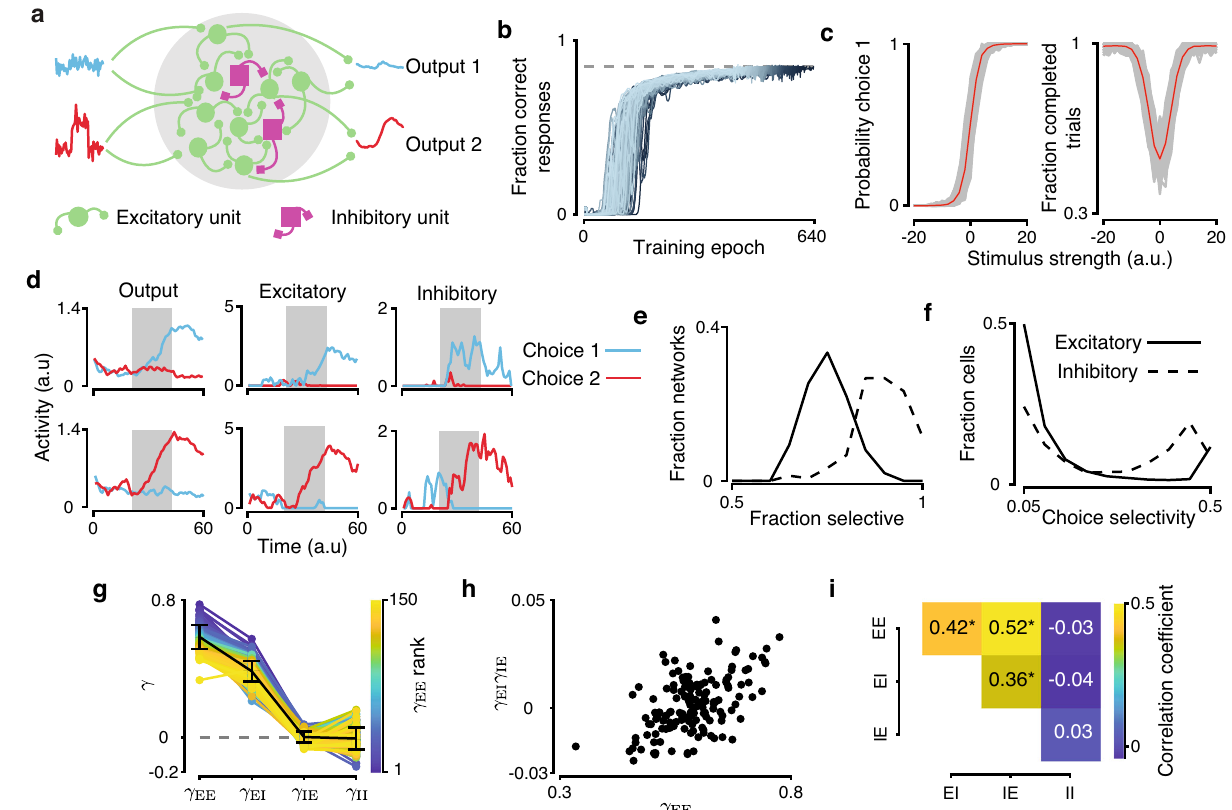
Fig. 5 | Inhibitory choice selectivity in trained recurrent neural networks. a RNNs are trained to compare two inputs and indicate which has higher mean by elevating the corresponding output. RNNs are composed of 100 excitatory and 25 inhibitory units. b We trained 150 RNNs to a consistent level of performance. RNN performance improved gradually during training. We stopped the training when the network performance reached 85% correct responses (gray dashed line). Lines show individual RNNs, color gradient indicates the network ’ s rank to reach 85% performance. c Psychometric functions (left) and probability of trial completion (right) for all trained RNNs (gray) and the mean across 150 networks (red). d Excitatory and inhibitory units in trained RNNs display choice selectivity. Traces show the activity of the RNN outputs (left), two excitatory units (center), and two inhibitory units (right) on two example trials with choice 1 (upper row, stimulus strength − 20) and choice 2 (lower row, stimulus strength 20). Gray shading